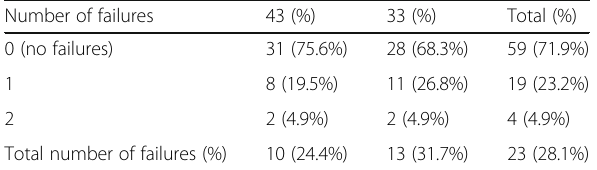
Table 6 Number of failures according to tooth type in the mandible for the . 027 ″ round TMA retainers (41 patients, 82 total bonded sites)